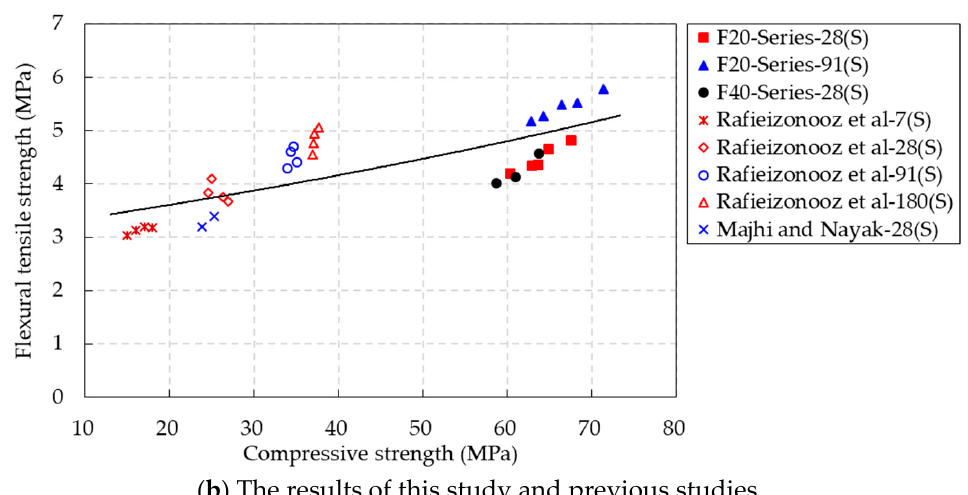
Figure 12. Relationship between the flexural tensile strength and compressive strength of the CBA concrete.